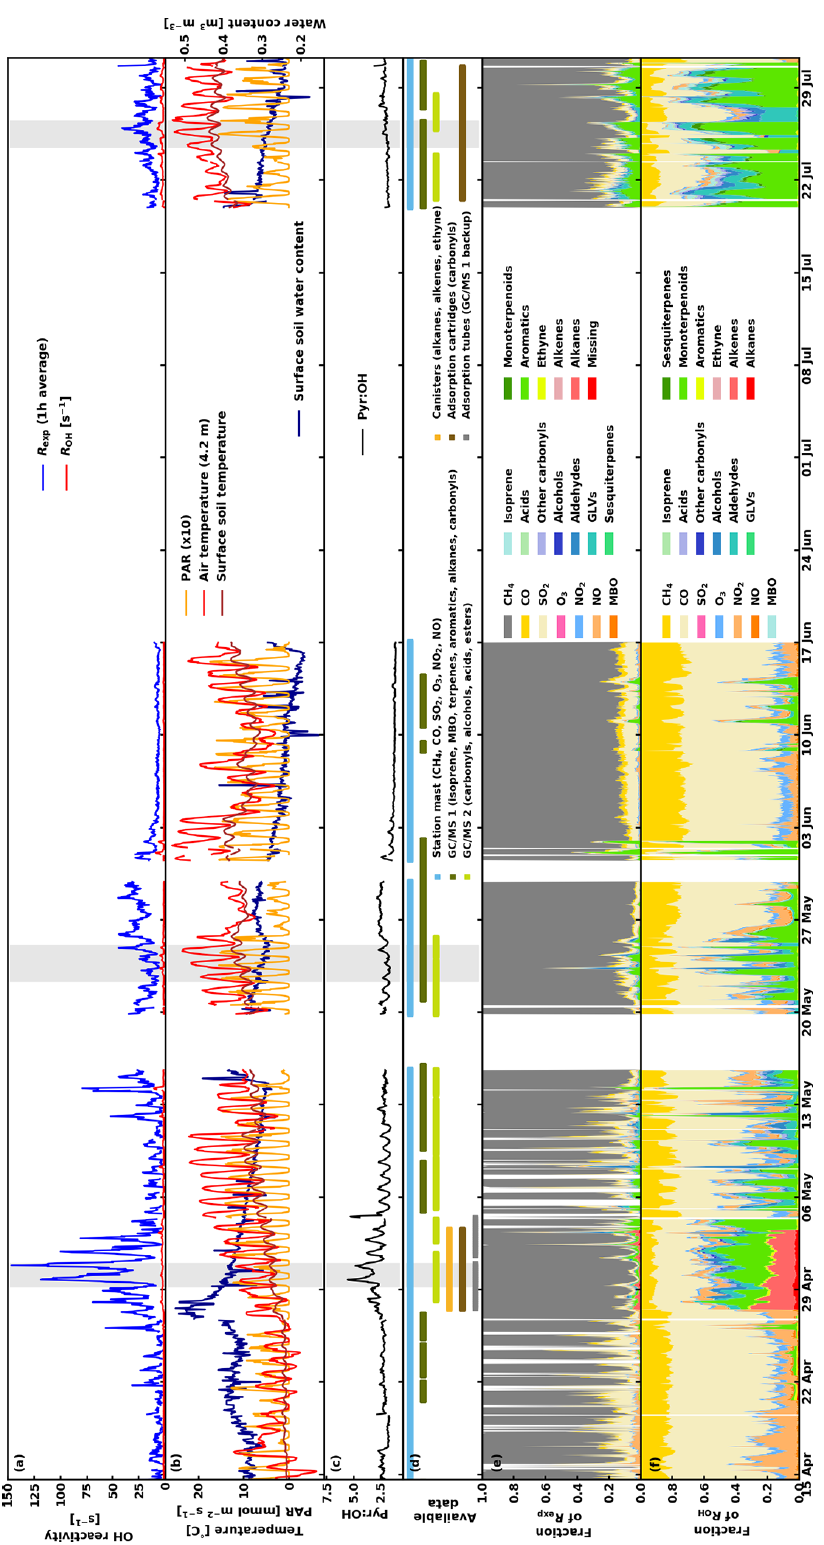
Figure 6. (a) Experimental total OH reactivity R exp (1h average) and calculated OH reactivity R OH , (b) environmental conditions (air and surface soil temperatures, as well as surface soil water content), (c) Pyr / OH in the CRM reactor, (d) data availability from the different instrumentation/sources, (e) fraction of experimental total OH reactivity, and (f) fraction of calculated OH reactivity. The periods shaded in grey in (a) to (d) represent the periods investigated with SOSAA (see Sect.